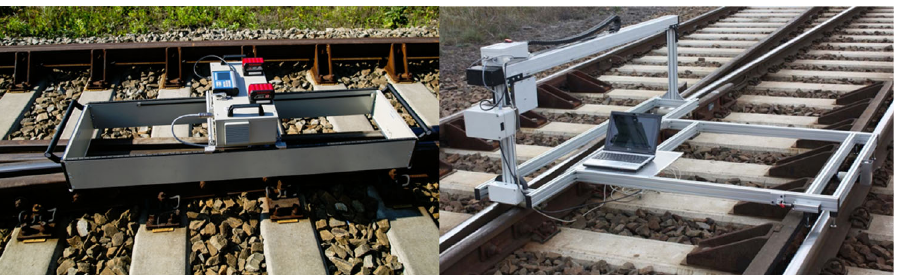
Fig. 2 Surface scanning methods for common